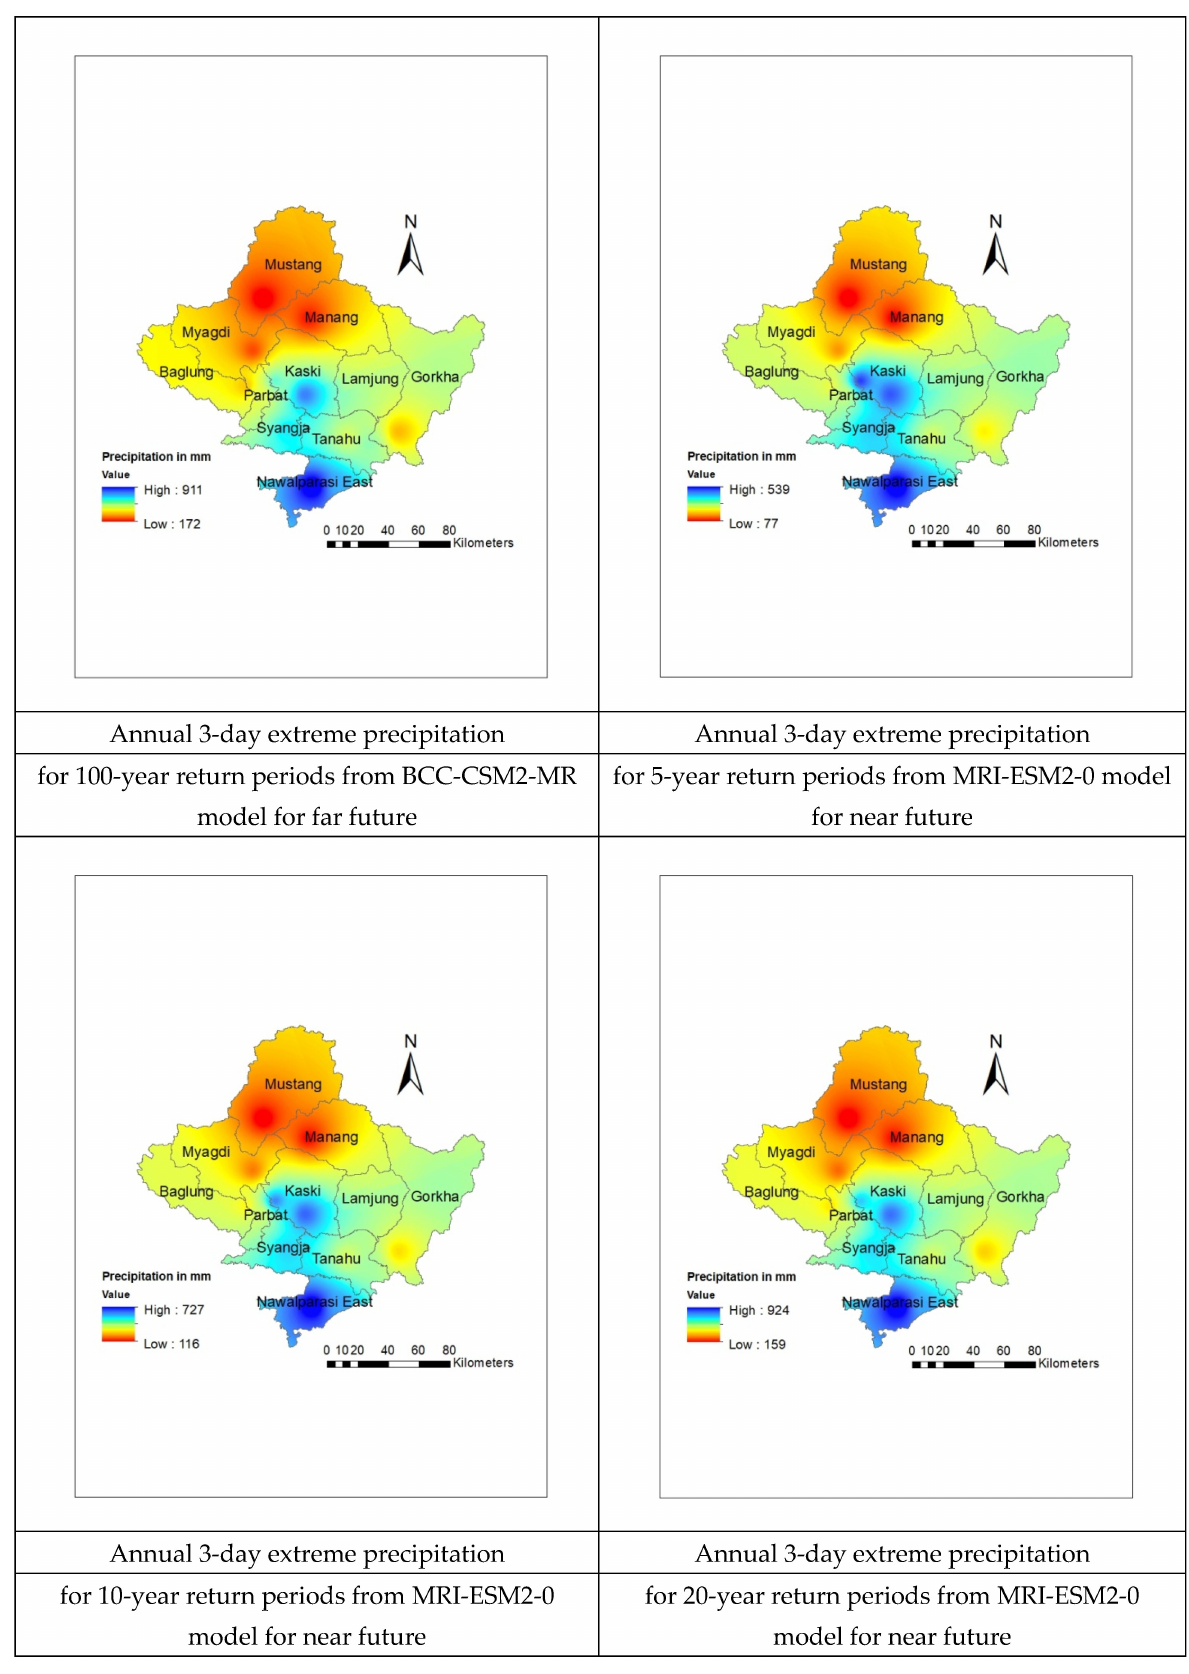
Figure A16. Cont